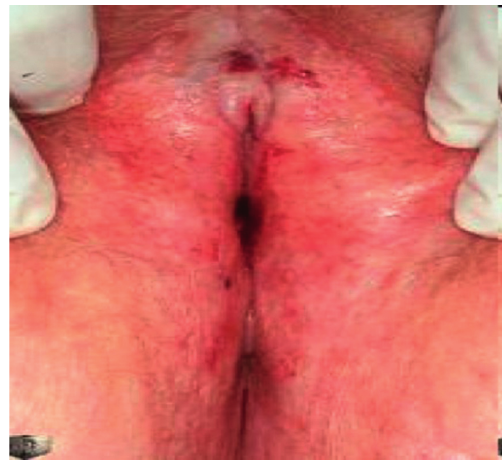
Figure 3: Late stage of vulvar lichen sclerosus with loss of labia minora and ulcerative lesions with hemorrhage seen on Table 2: Clinical features of vulvar lichen sclerosus.